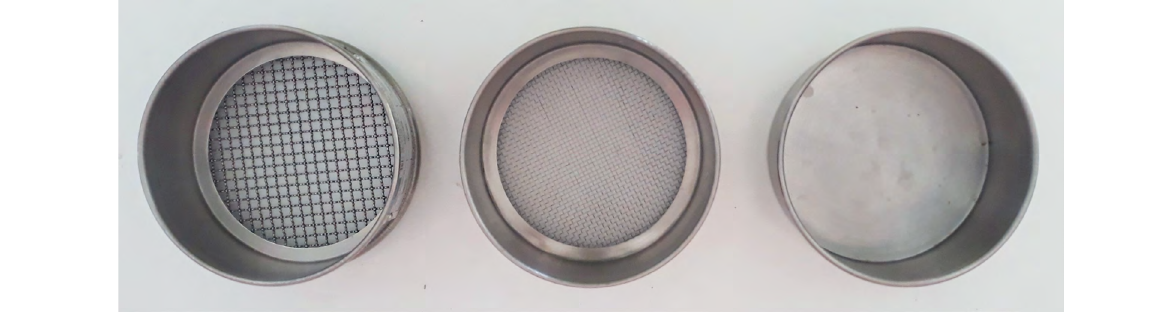
Figure 4. Sieving system used to filter the almonds after the masticatory efficiency test. Observe the sieves of several different meshes.